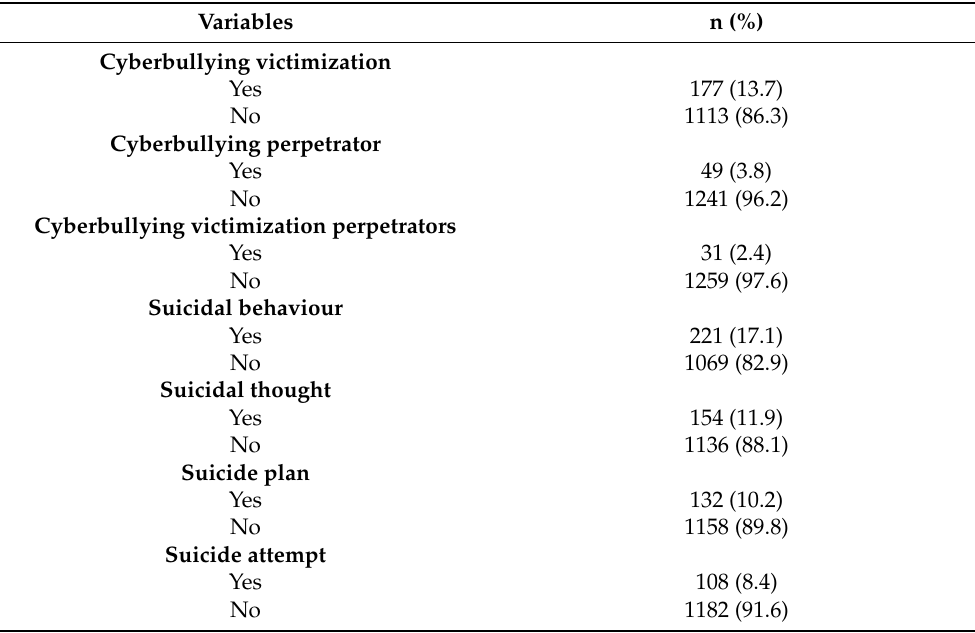
Table 2. Prevalence of cyberbullying and suicidal behaviour among adolescents in secondary schools in Peninsular Malaysia (n = 1290).